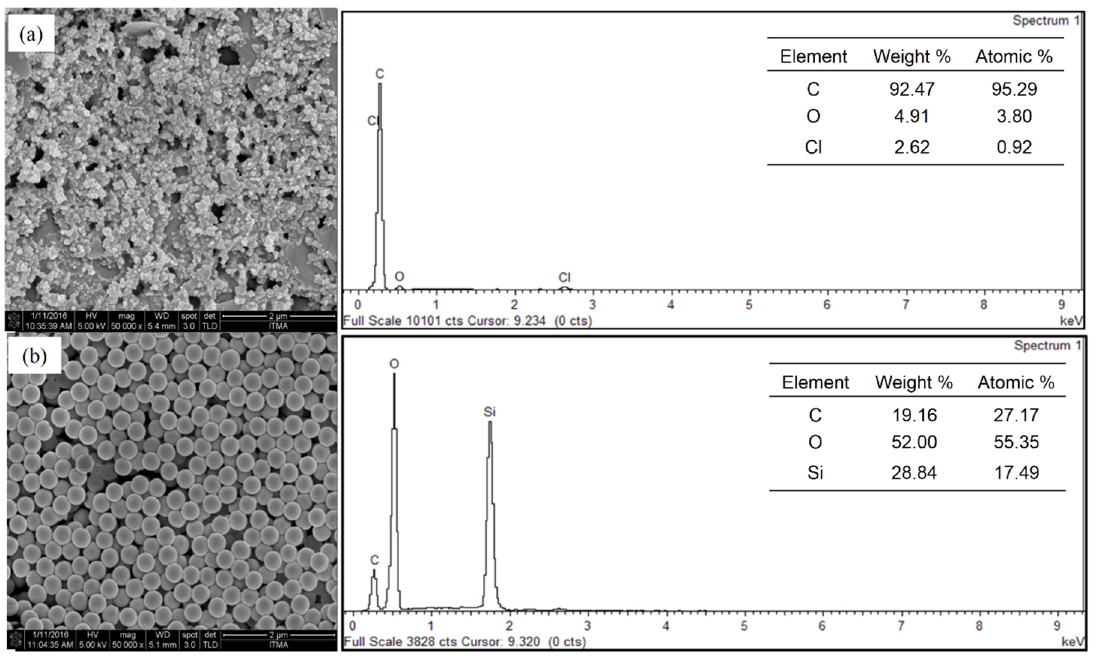
Figure 3. FESEM images coupled with EDX spectra for the ( a ) bare SPCE and ( b ) SiNPs/SPCE.